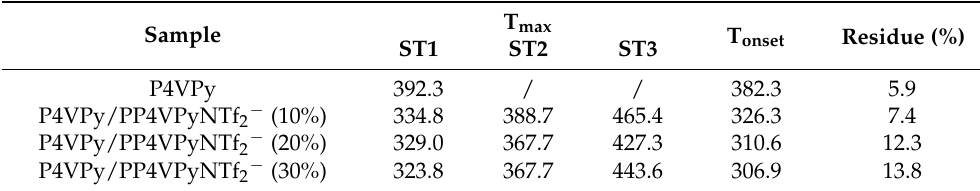
Table 1. Maximum weight loss rate T max , onset of thermal degradation T onset and percentage of final residue, of P4VP NFs, and NFs with different PIL contents.